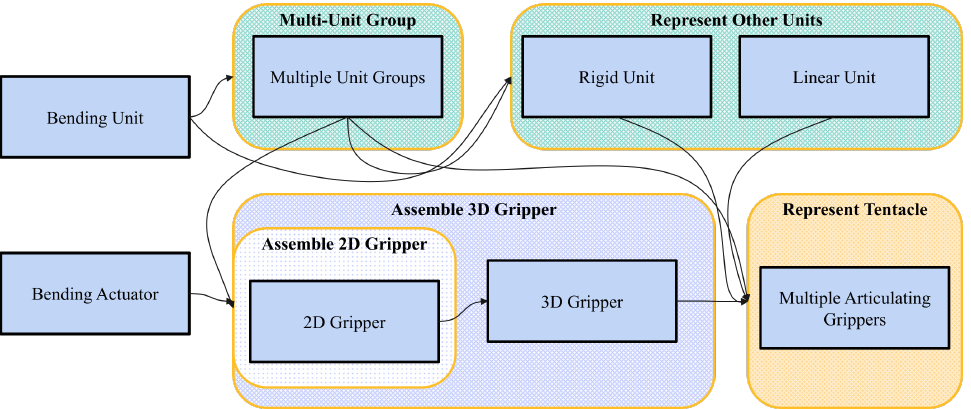
Figure 9. ESP framework for generating candidate designs for a multi-gripper